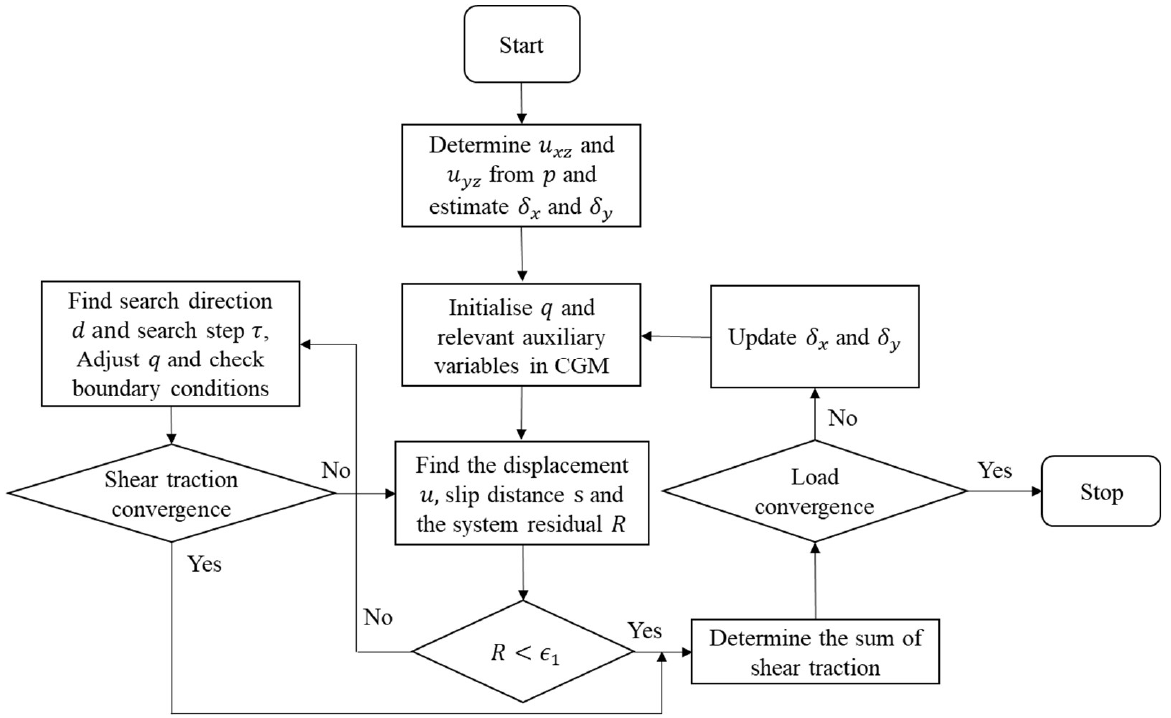
Figure A1. Flow chart of the algorithm for the tangential contact solver.